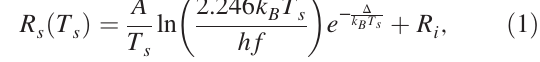
temperatures, 2.0, 1.8, 1.6 K (symbols) along with results from a thermal feedback model calculation for each temperature with values of the thermal boundary resistance matching the exper- imental quench fields (solid lines).